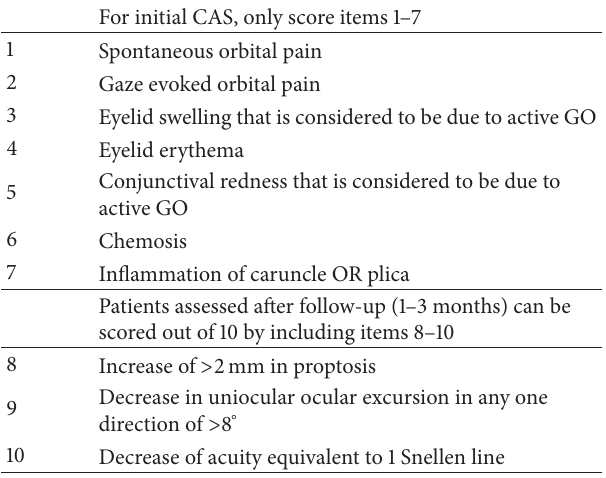
Table 3: VISA Inflammatory Index (I) (Dolman and Rootman 2006 [25], ITEDS modified). Patients with moderate inflammatory index (less than 4 of 10) are managed conservatively. Patients with high scores (above 5 of 10) or with evidence of progression in the inflammation are offered a more aggressive